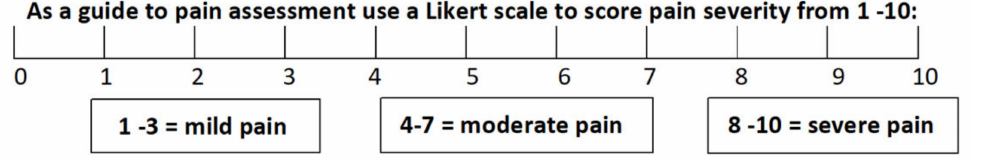
Figure 1. Likert scale for pain